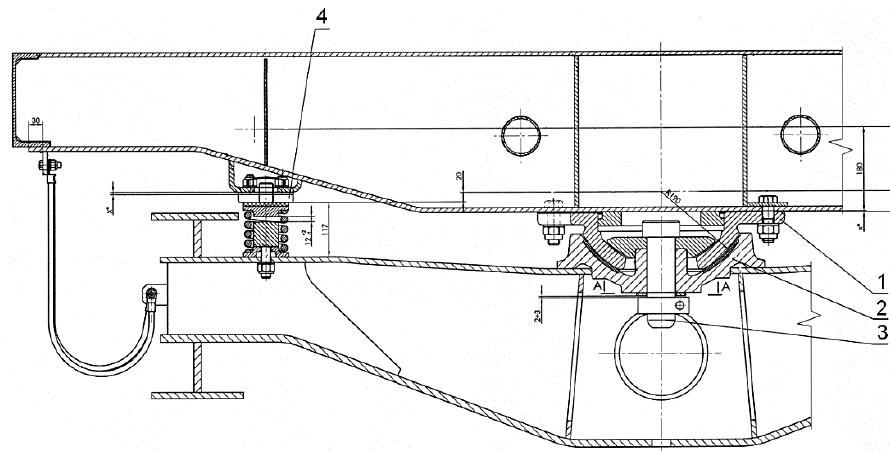
Figure 4. Connection between the body and the bogie frame of the railway freight vehicle. 1—pivot, 2—centre bowl, 3—pivot pin, 4—slide bearer, source: based on technical documentation.